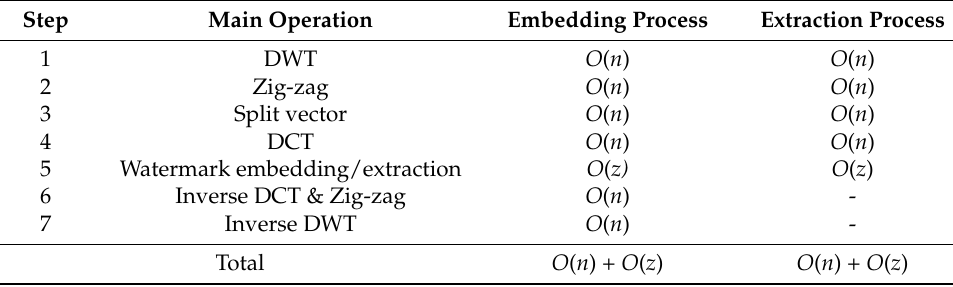
Table 1. Time complexity for an image with the size n = m × m